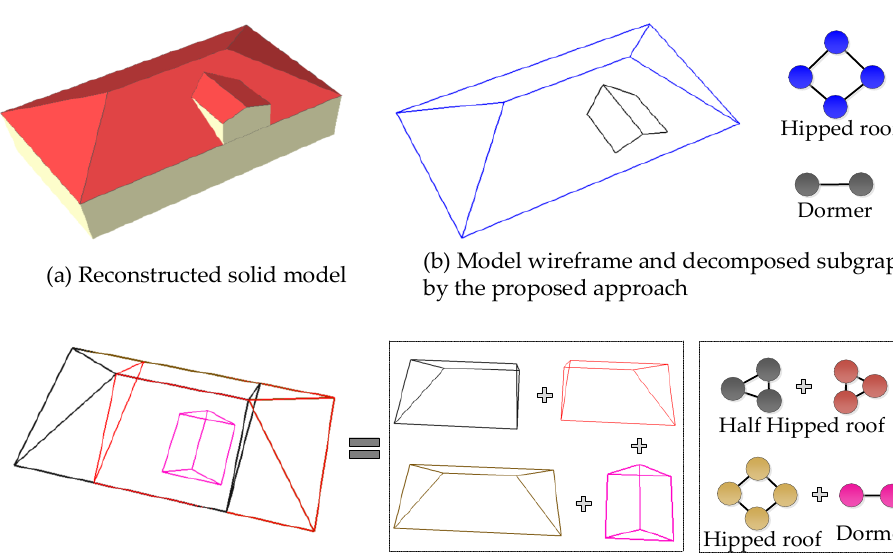
Figure 12. Comparison between standard matching approach ( b ) and the proposed unambiguous decomposition ( c ) for the same building ( a ).